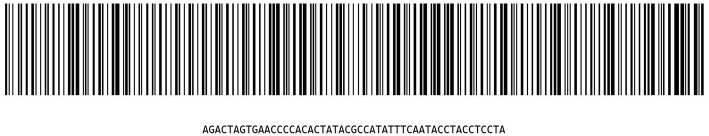
DNA tag barcode of B. dussumieri. As an example, a DNA tag barcode is generated for the purpose of fast and precise identification in the teleost goby Boleophthalmus dussumieri.